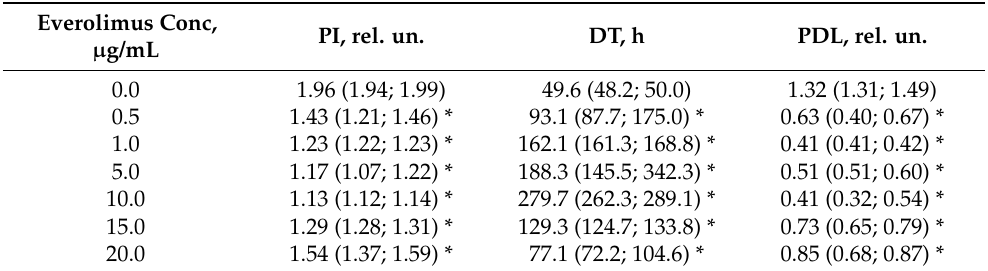
Proliferation indices of HTFs cultures of control (0.0 µ g/mL) and everolimus (0.5–20.0 µ g/mL) groups, Me (Q 1 ; Q 3 ). Everolimus